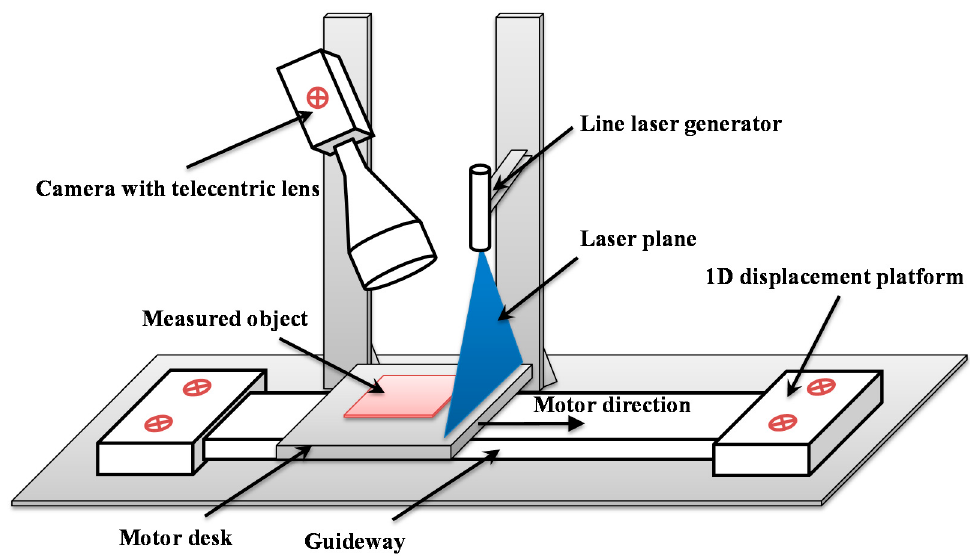
Figure 1. Telecentric surface metrology system based on laser scanning.